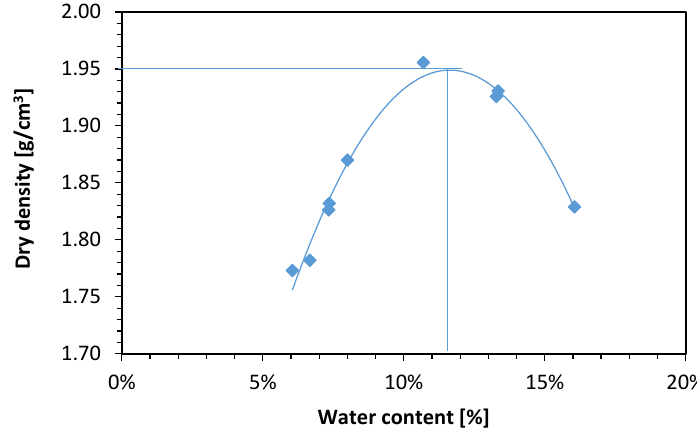
Figure 3. Soil compaction curve based on the Proctor test.